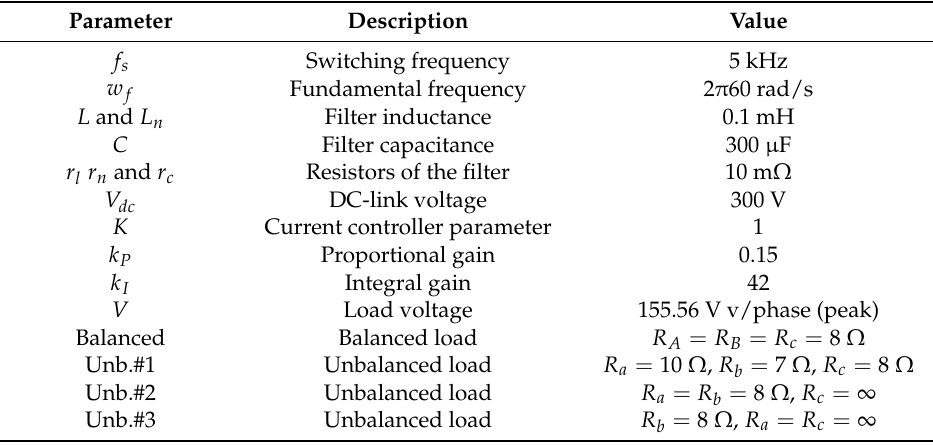
Table 1. Electrical and controller parameters of three-phase four-leg